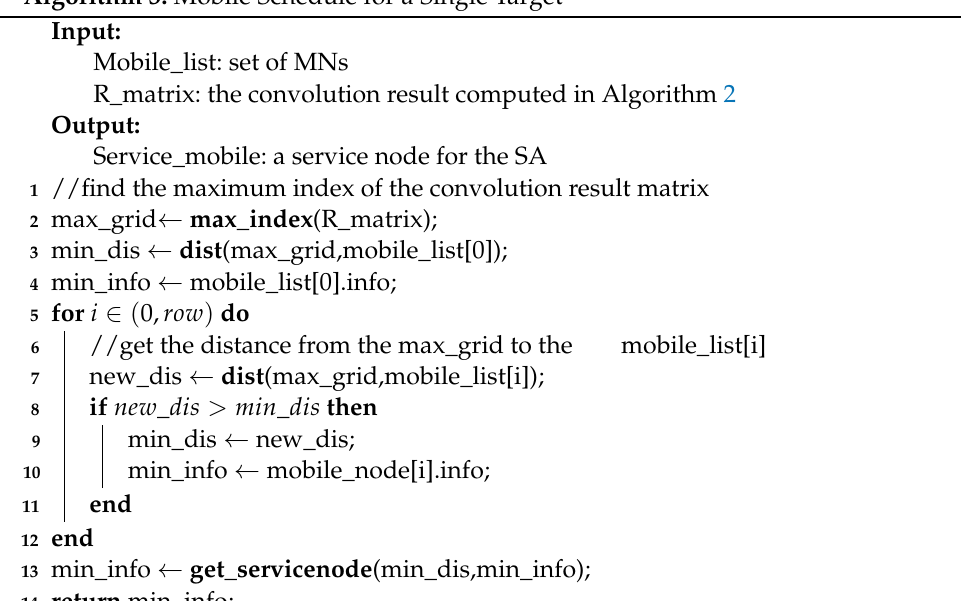
Algorithm 3: Mobile Schedule for a Single